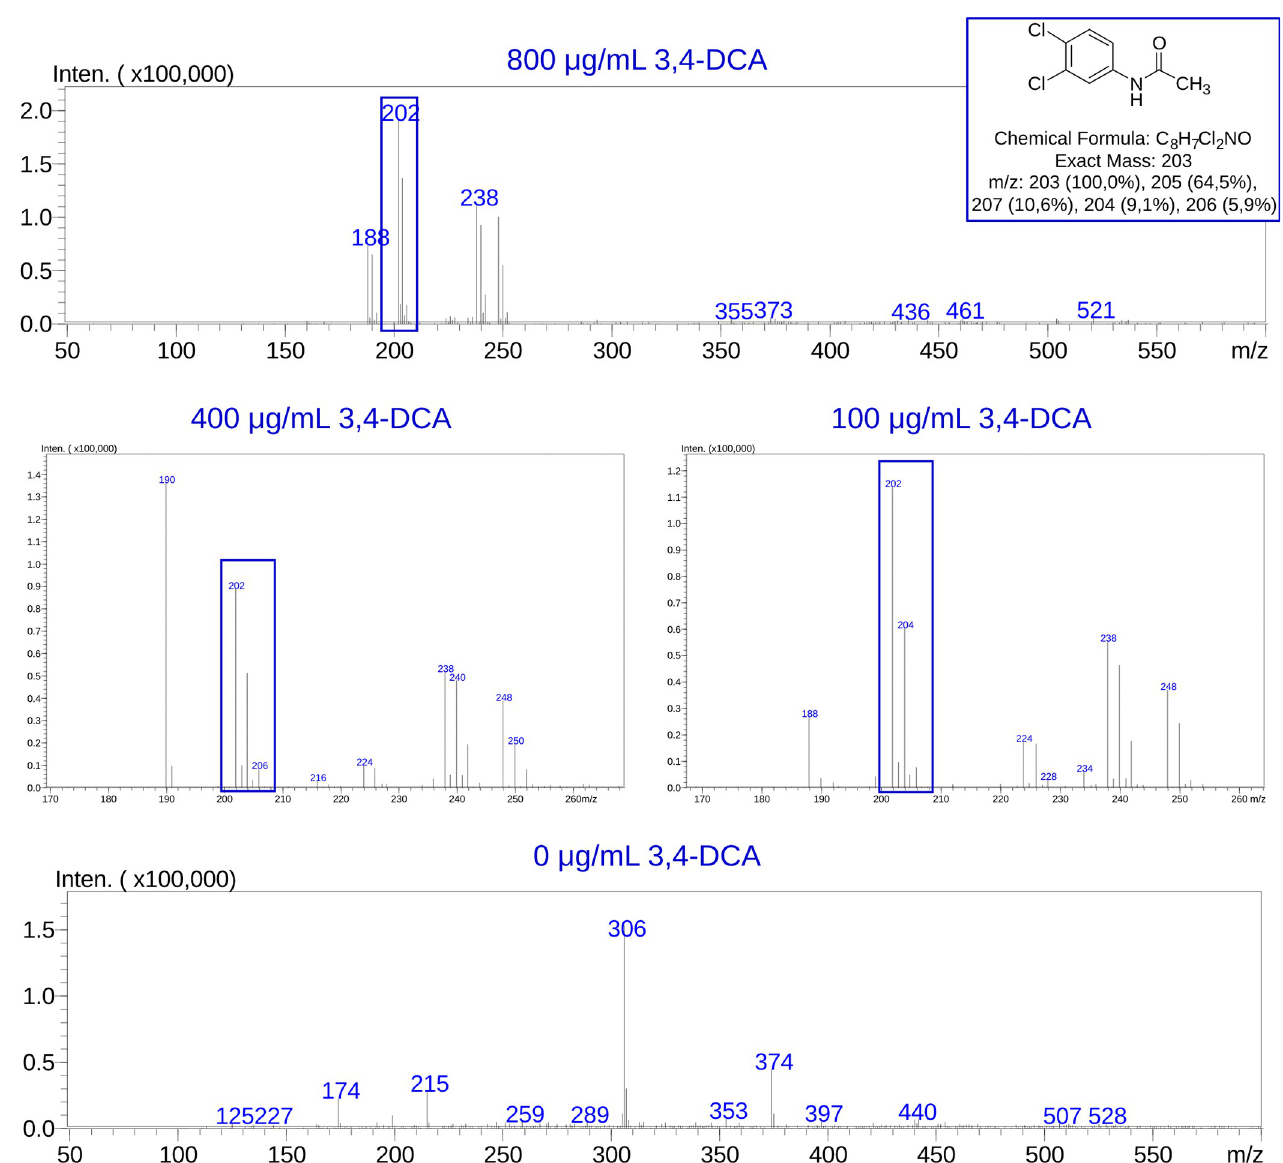
Fig 5. LC-MS analysis of xenobiotic-amended culture medium, following growth of isolate #25- T . paurometabola DSM 20162 T . The actinobacterium was allowed to grow in Nutrient Broth (NB) medium amended with 800, 400, 100 or 0 μ g/mL of 3,4-dichloroaniline (3,4-DCA). The culture medium was then subjected to organic extraction and LC-MS analysis, to specifically look for possible N- acylated metabolic derivatives of the parent compound. Negative ion mode ESI spectrometry detected the characteristic isotopic pattern (peak intensity ratio 9:6:1, retention time ~8.5 min) of a bis-chlorinated compound with mass corresponding to the N- acetylated form of 3,4-DCA [M-H] – (peaks and chemical structure in blue frames). This compound was absent in the extract of the culture that lacked the parent arylamine (0 μ